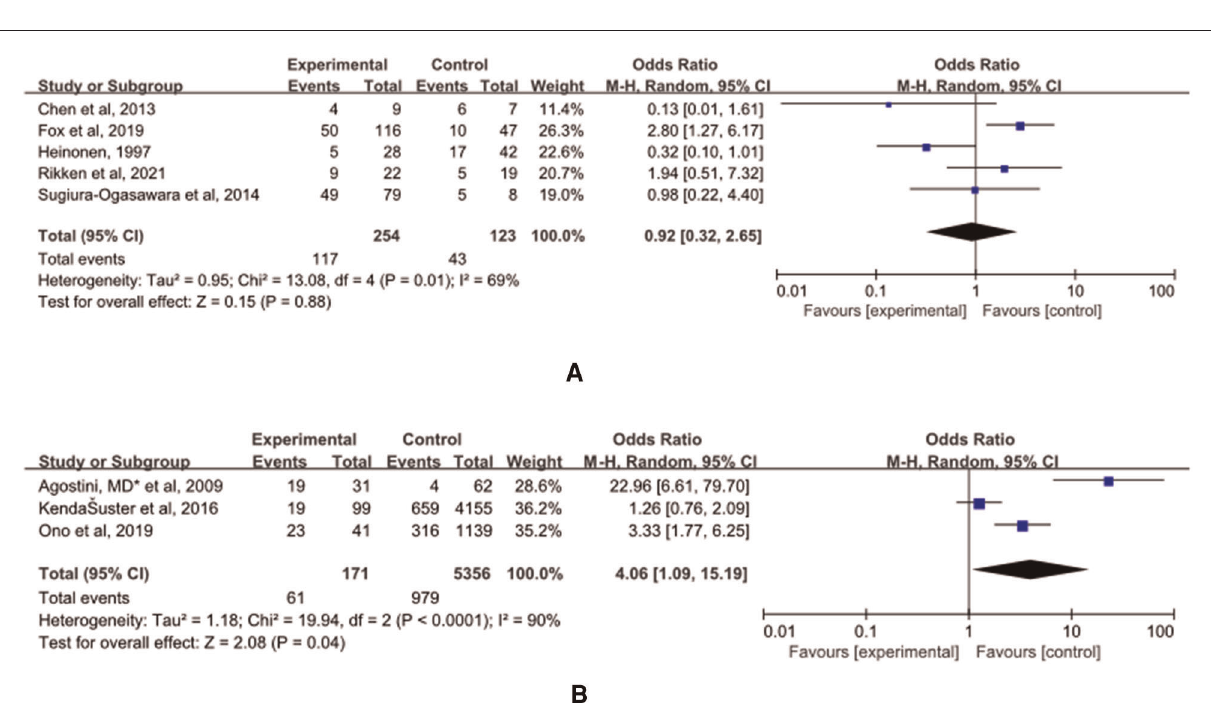
FIGURE 8 | Effect of hysteroscopic metroplasty on caesarean section. ( A ) The control group of untreated women with septum uterus, and the study group was patients who underwent hysteroscopic surgery. ( B ) The control group of these articles was women with intact uterus, and the study group was patients who underwent hysteroscopic